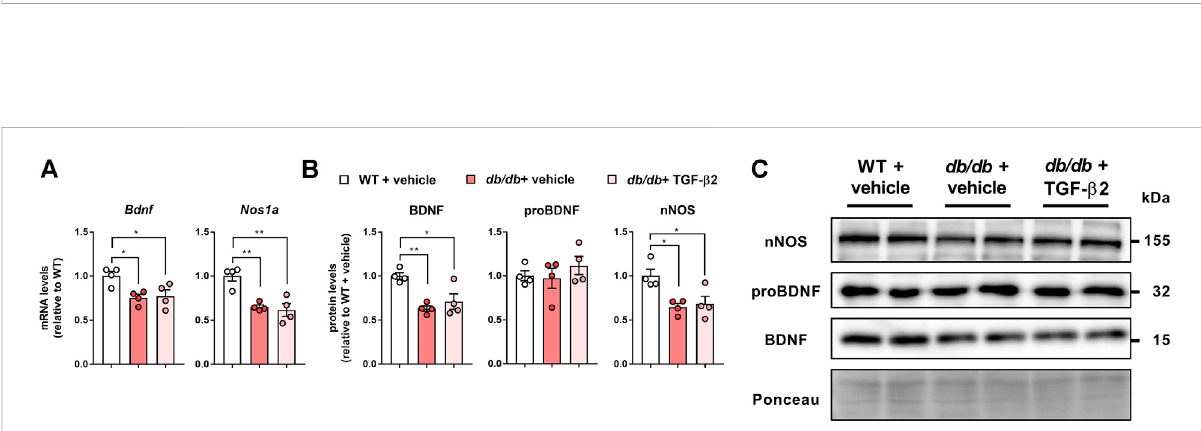
FIGURE 4 TGF- β 2infusion doesnot affectthelowmRNA andproteinexpression ofBDNFandnNOS in db/db mice (A) Bdnf and Nos1a mRNAexpression, and (B) representative immunoblots and (C) quanti fi cation of BDNF, proBDNF, and nNOS protein levels in the hippocampi of WT, db/db + vehicle, and db/db +TGF- β 2mice.ThePonceauSsignalintensitywasusedasaloadingcontrolforwesternblotanalysis.Dataarepresentedasthemean±SE ( n = 4/group). The dots represent individual data points. ** p < 0.01; * p < 0.05.